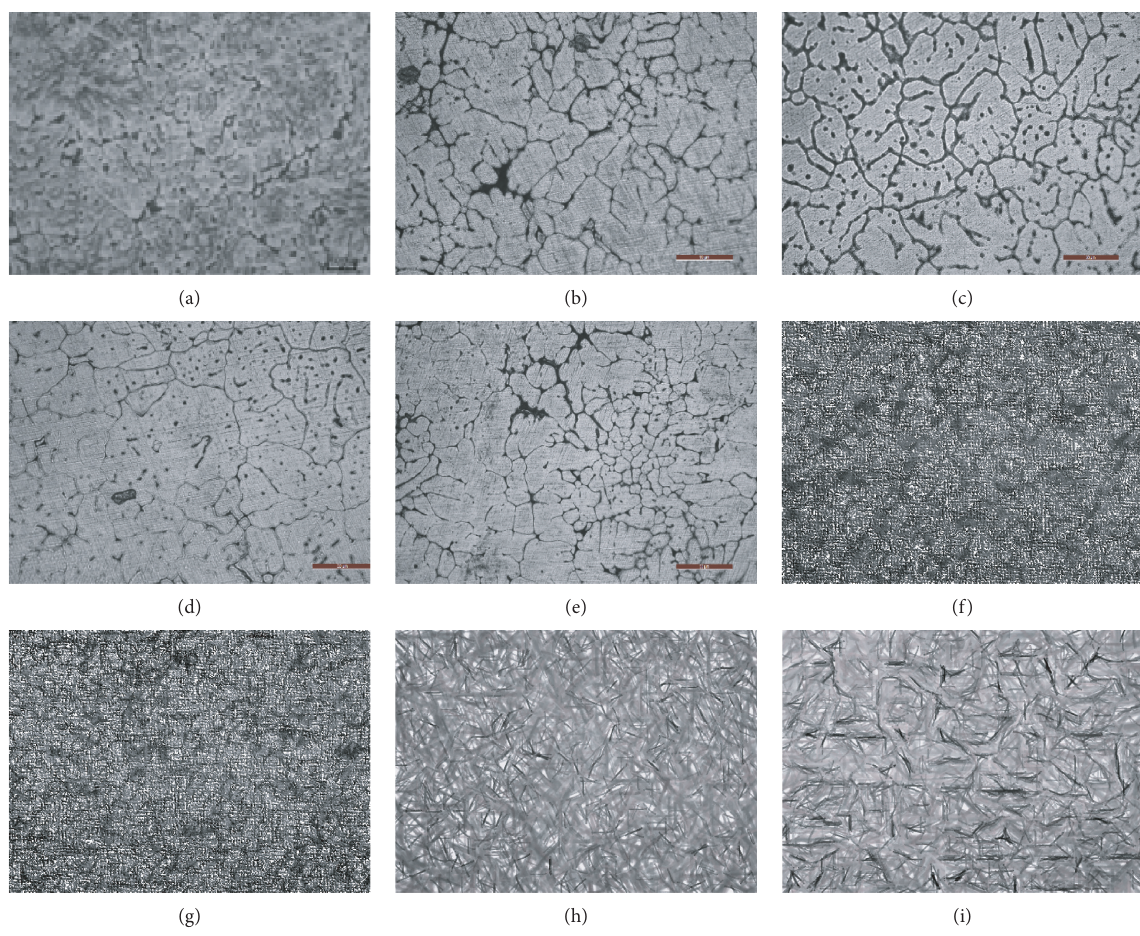
Figure 4: Microstructure examinations of pure Al7075, as-cast, and age-hardened specimens. (a) Al7075 alloy. (b) Al7075/B cast. (c) Al7075/B 4 C-8 wt.% as-cast. (d) Al7075/B 4 C-10 wt.% as-cast. (e) Al7075/B 4 C-12 wt.% as-cast. (f) Al7075/B 4 C-6 wt.% age-hardened. (g) Al7075/B 4 C-8 wt.% age-hardened. (h) Al7075/B 4 C-10 wt.% age-hardened. (i) Al7075/B 4 C-12 wt.%